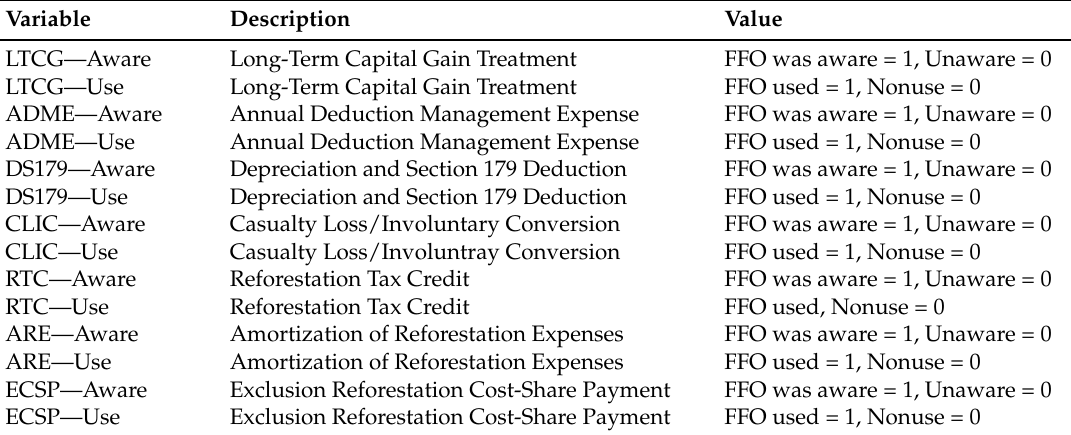
Table 1. Summary of dependent